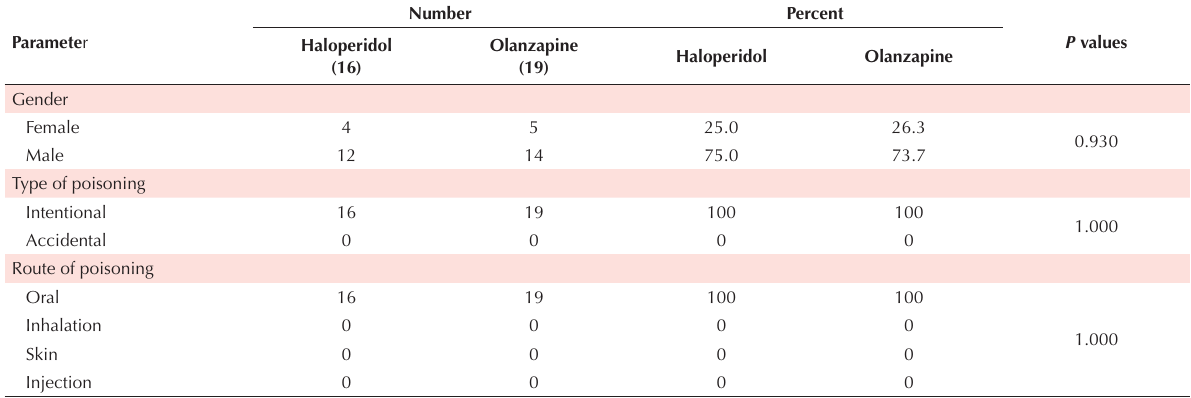
Table 1. Demographic data (qualitative)